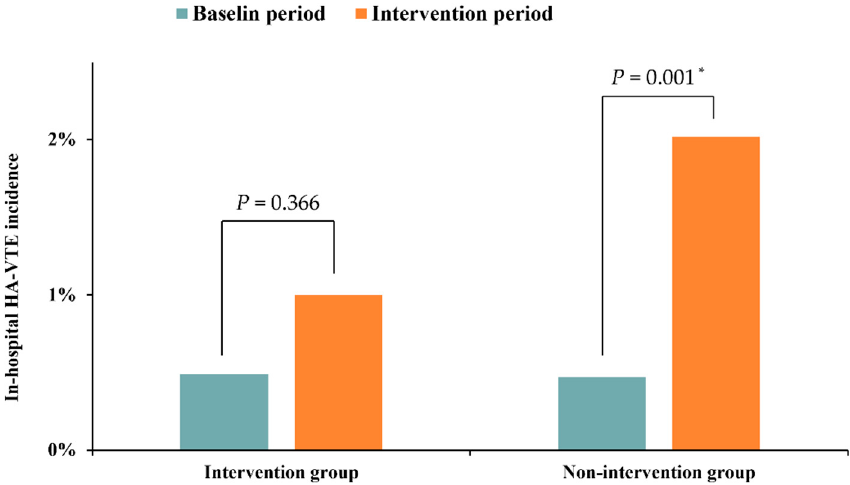
Figure 5. Change in in-hospital HA-VTE Event from baseline to the end of intervention. * p < 0.05.